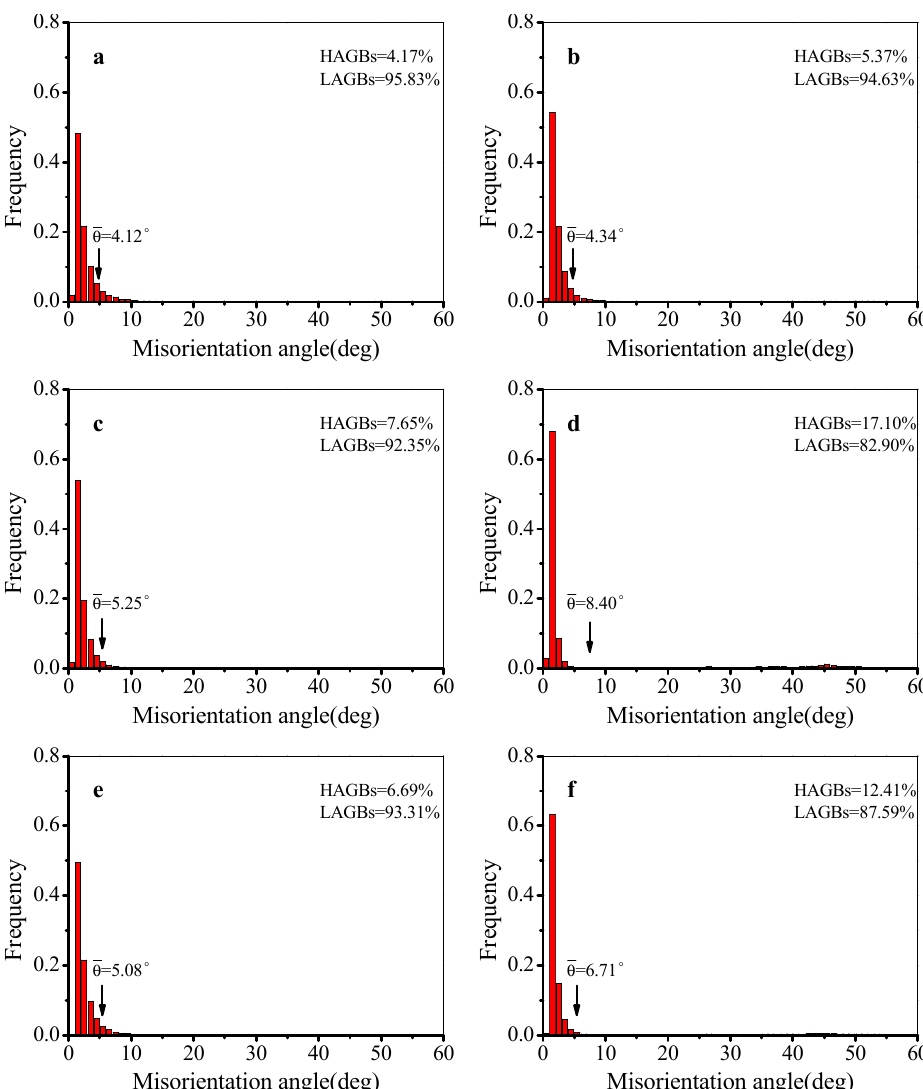
. ε = 0.0003 s − 1 ; ( e ) T = 200 ◦ C,